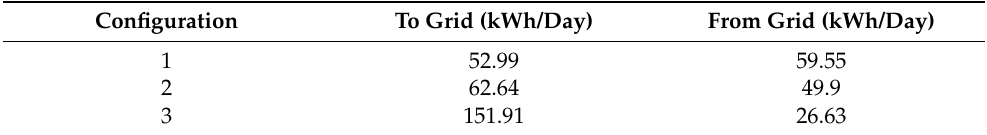
Table 2. Energy flow between the utility grid and HRES.